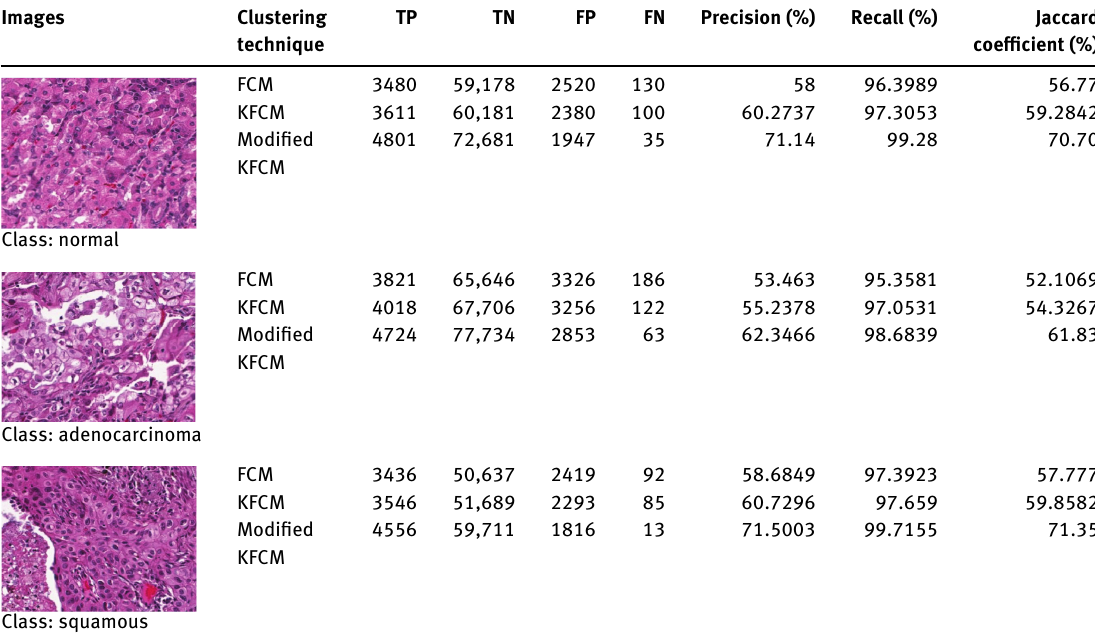
Table 1: Precision, recall, and Jaccard coeflcient comparison of the proposed and existing methods.